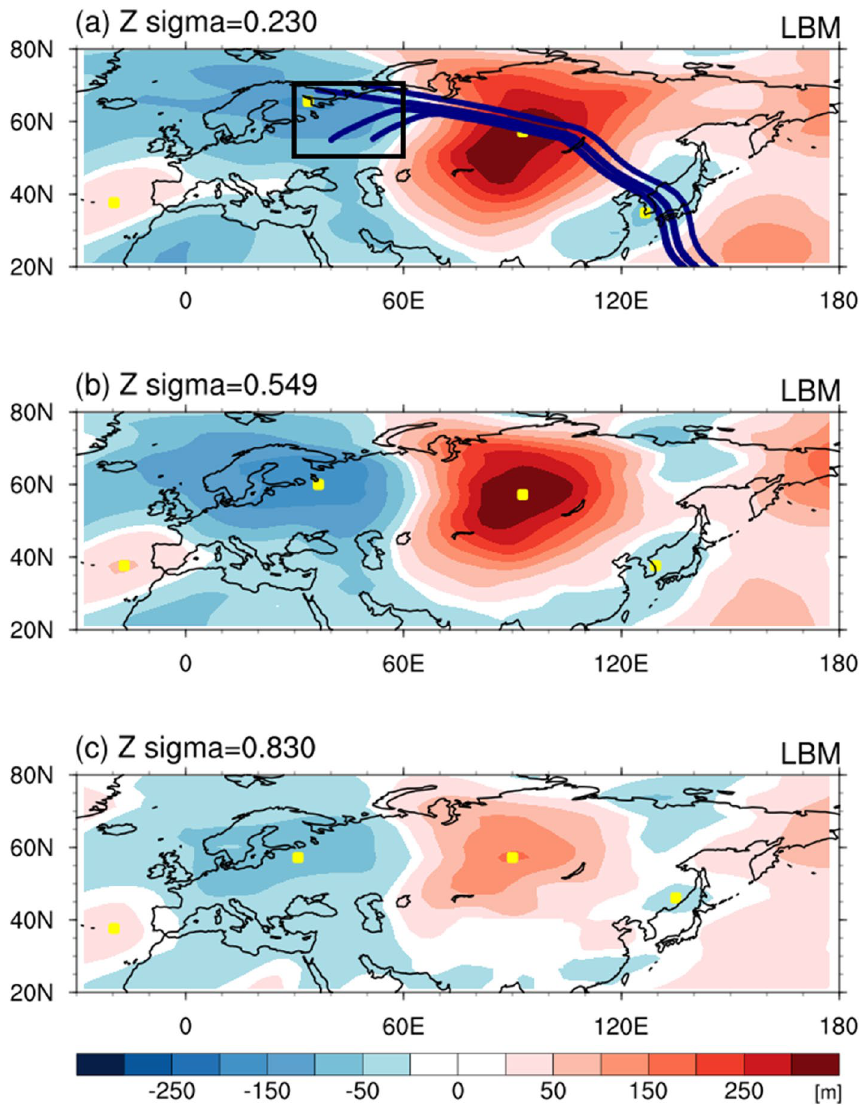
Figure 4. Simulated atmospheric circulation anomalies in response to vorticity forcing. ( a ) 0.230σ, ( b ) 0.549σ, and ( c ) 0.830σ geopotential height anomalies (shading, m) averaged over 16–20 days of output in response to vorticity forcing. In ( a ), navy lines represent the Rossby wave ray path for waves with the zonal wavenumber 2, while the black box indicates the vorticity forcing region (northwestern/central Russia; 50–70°N, 30–60°E). Maps were generated using the NCAR Command Language Version 6.4.0 (http:// www. ncl. ucar.